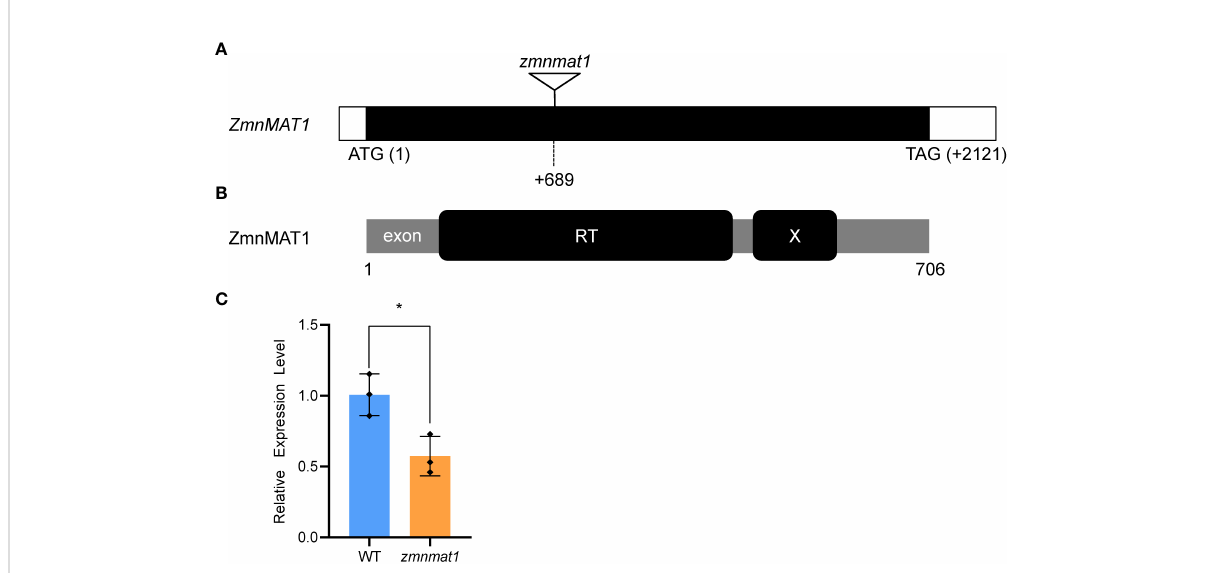
FIGURE 2 Cloning and identi fi cation of the ZmnMAT1 gene. (A) Structure of the ZmnMAT1 gene and positions of Mu insertion (triangle) in zmnmat1 mutant. (B) The ZmnMAT1 protein contains a RT motif (a reverse transcriptase domain) and an X motif (an RNA binding and splicing domain). (C) qRT-PCR analysis of ZmnMAT1 expression in 10 DAP kernels of zmnmat1 mutant and WT siblings. Expression level was normalized against ZmActin . Values are shown as the average ± S.E. (* p < 0.05, Student ’ s t